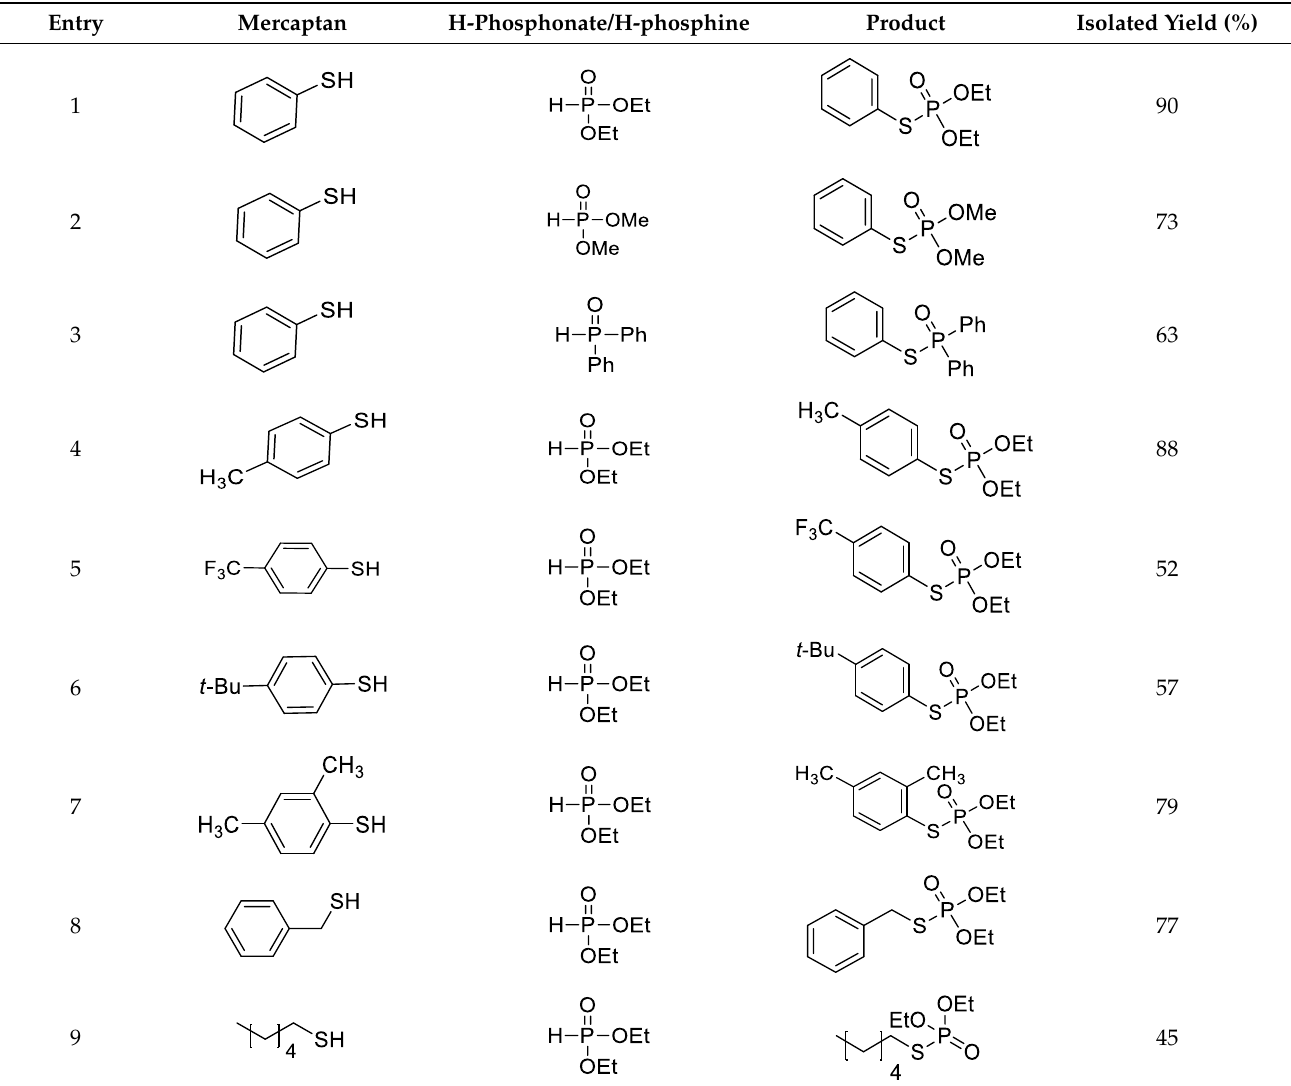
Table 3. Examples and scope of the Fe(II)Pc catalyzed cross-dehydrogenative coupling (CDC) reactions using DIPA as base [64] .